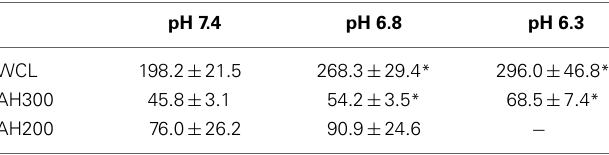
Table 2 | Effect of pH on AV node conduction characteristics.